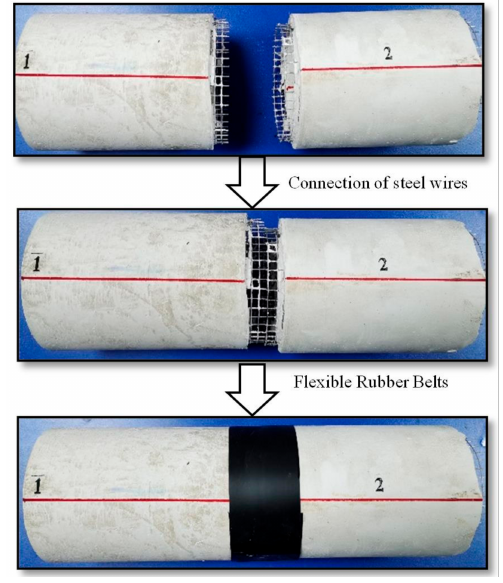
Figure 2. Flexible joints model.